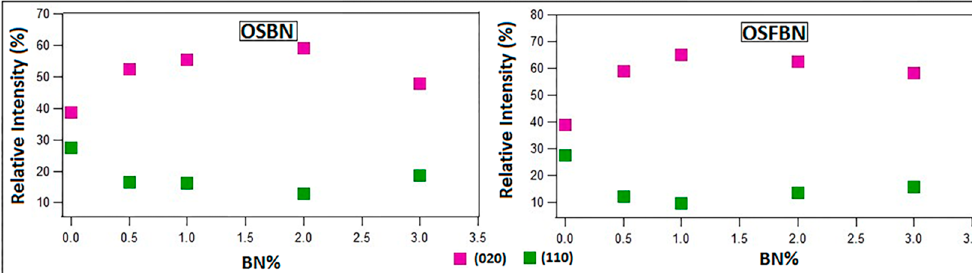
Figure 4. (020) and (110) relative intensity variation with BN content. Table 2. (020)/(110) relative intensity ratios of nanocomposites.